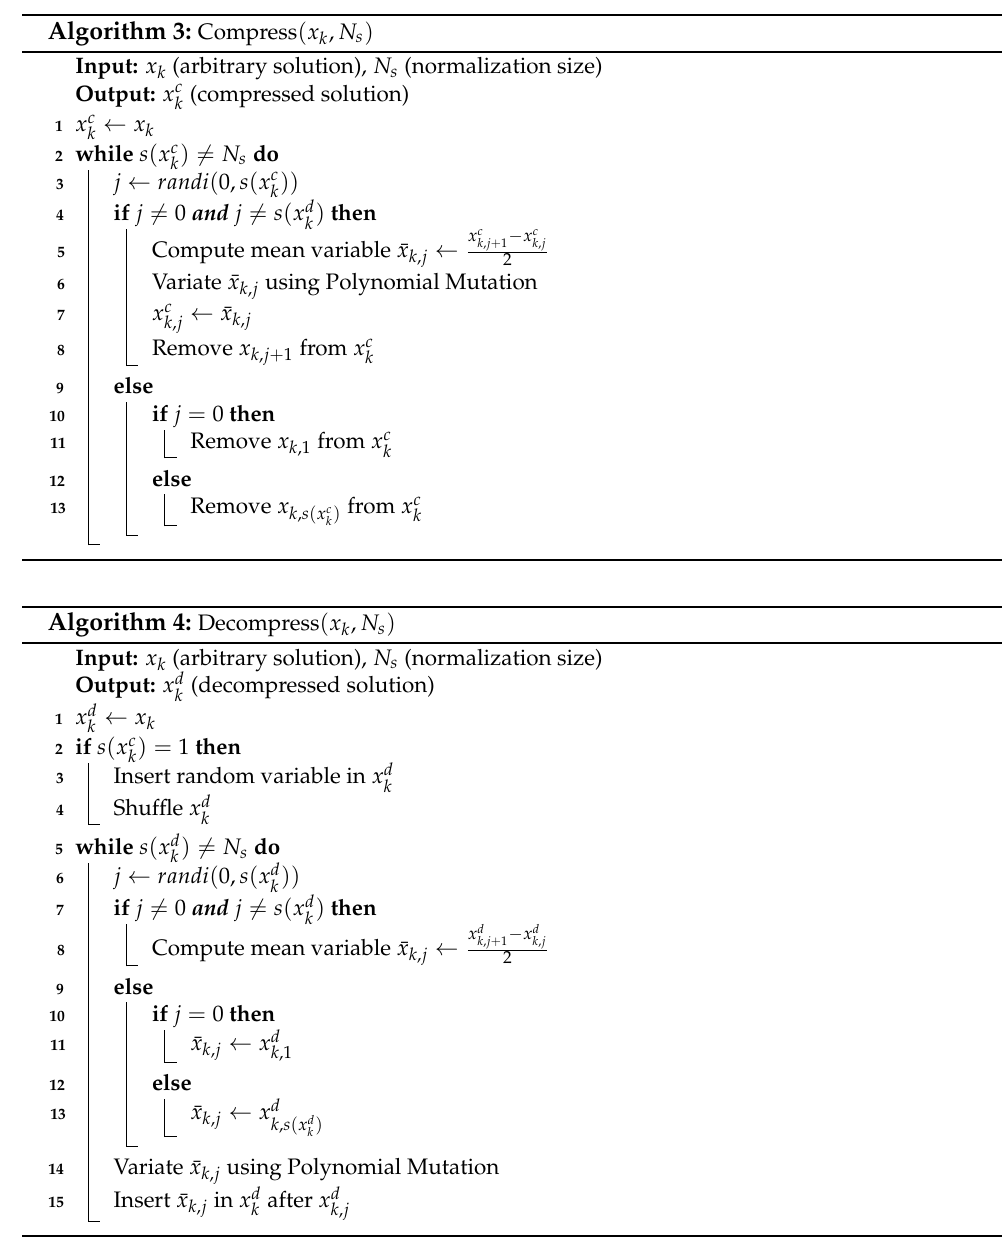
Algorithm 3: Compress ( x